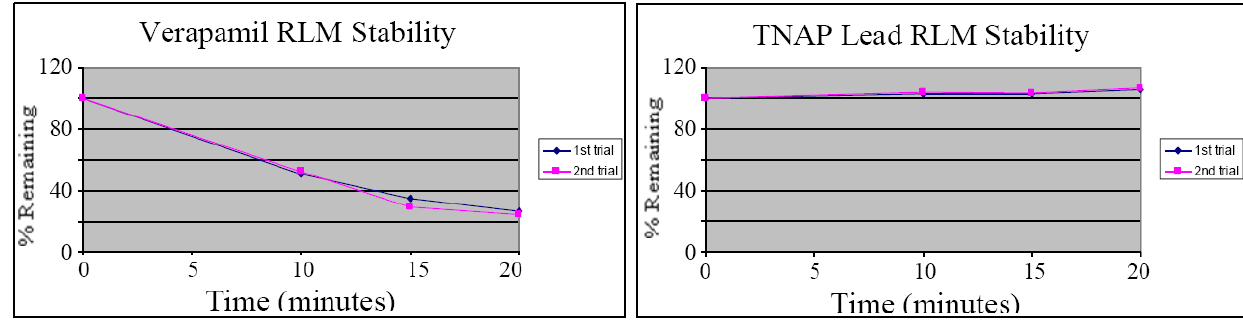
Figure 4. Liver microsome stability of CID-2931238 (duplicate